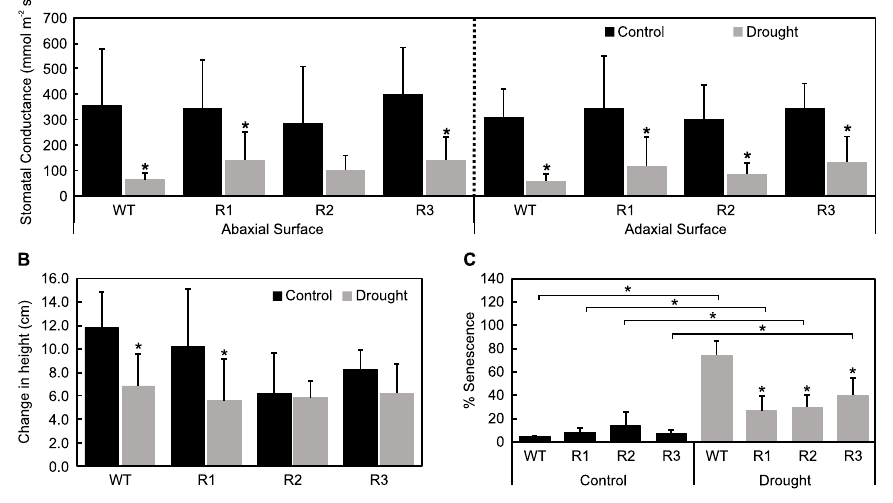
Figure 4. Physiological changes in SPL9 -RNAi alfalfa under well-watered and drought conditions: ( A ) Stomatal conductance of plants measured around midday. The asterisks indicate significant differences between treatments ( p < 0.05, where n = 8, two-way ANOVA and Sidak test). ( B ) Plant height difference between initiation and end of trial (12 days): the asterisks indicate significant differences between treatments ( p < 0.05, where n = 10, two-way ANOVA and Sidak test). ( C ) Percent of total leaves that were senesced after plants were exposed to 12 days of control and drought treatments: the asterisks indicate significant di ff erences within treatments (Dunnett’s test), and the bars indicate significant di ff erences between treatments (Sidak test) ( p < 0.05, where n = 10, two-way